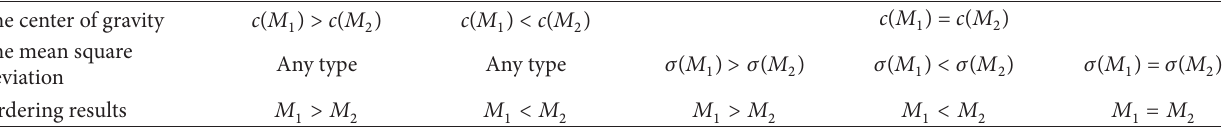
Table 1: Comparison rules for two trapezoidal fuzzy